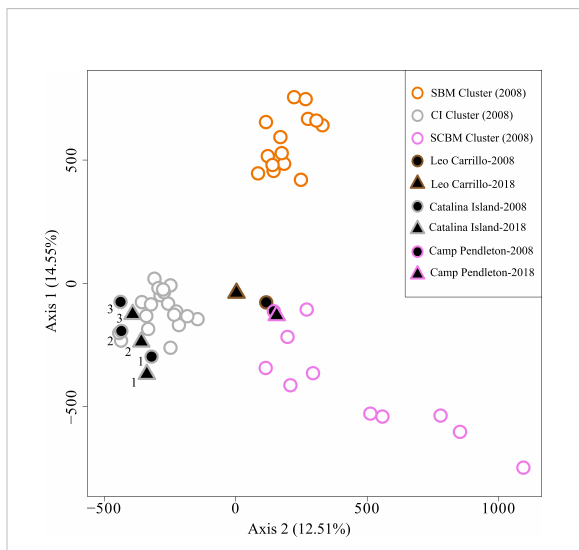
FIGURE 5 Factorial Correspondence Analysis (FCA) of Macrocystis pyrifera microsatellite alleles. Samples from 2008 and 2018/19 are represented with circles and triangles, respectively. Black fi lled symbols are for 2008-2018/19 speci fi c comparisons made in this study while open symbols are for additional 2008 samples from Johansson et al. (2015). Samples with data only from 2008 are used here to represent the spatial genetic structure of the before and after samples studied here in the overall regional context. The outline color in symbols represents the genetic coancestry clusters identi fi ed in Johansson et al. (2015) using STRUCTURE. Samples collected at both dates, 2008 and 2018/19, clustered together re fl ecting minor changes in genetic